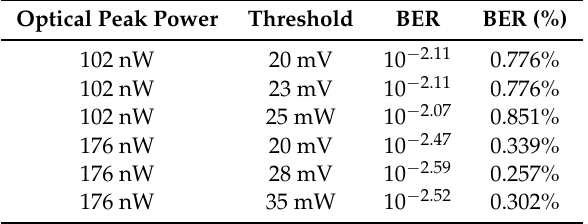
Table 6. Measured BER for the optical communication parameter set